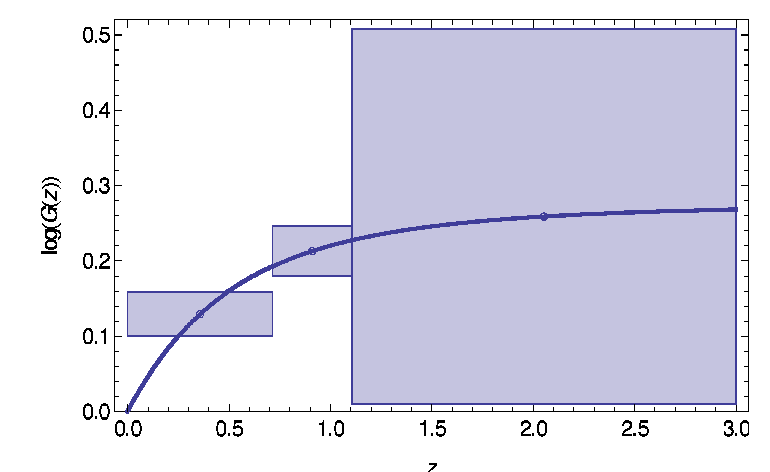
Fig. 26 Error bars on the growth function G ( z ) with three redshift bins while marginalizing over the h i s. The exact height of the error bars respectively are ( 0 . 029 , 0 . 033 , 0 . 25